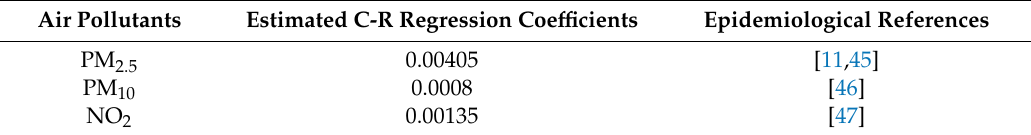
Table 1. The concentration-response (C-R) coe ffi cients for PM 2.5 -, PM 10 -, and NO 2 -induced